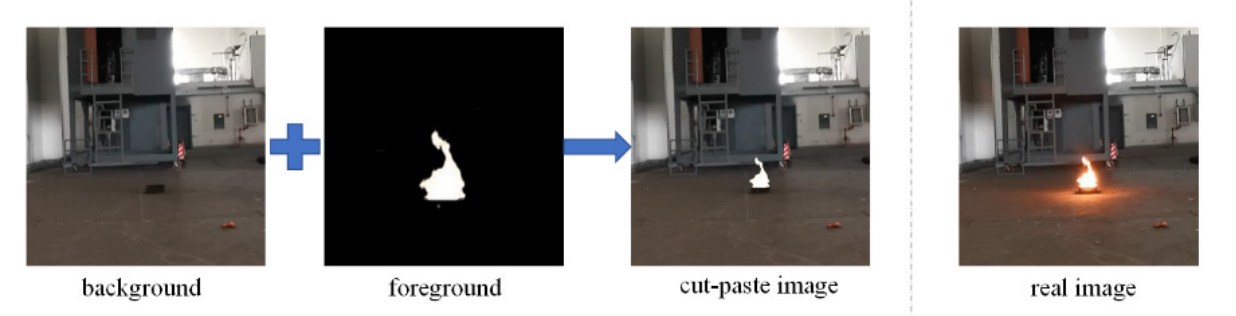
Figure 1. Schematic diagram of cut-paste algorithm.